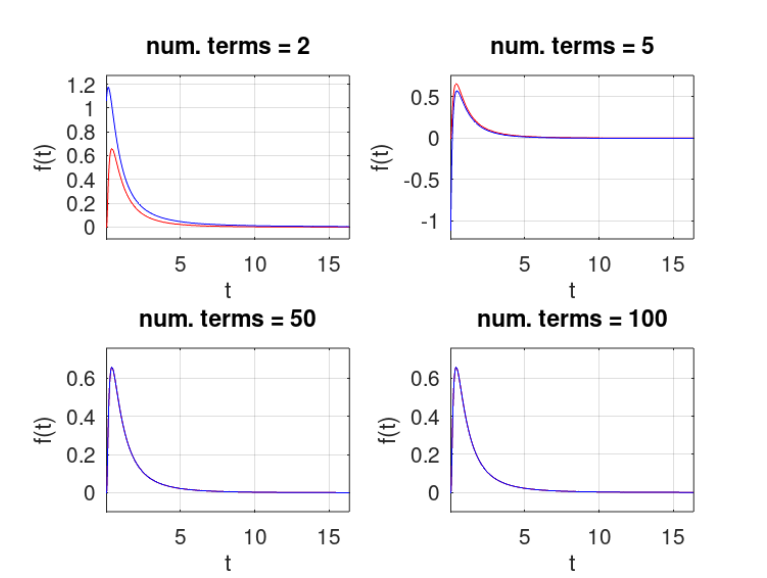
Figure 2. Numerical computation of f ( t ) (45) for 2,5,50, and 100 terms of the series. To make another fair comparison, we computed the FT of the resulting functions. In Figure 3, we present the corresponding absolute values on a logarithmic scale. A sampling interval equal to 0.0001 was used to obtain the sampled signal that was transformed using the fast Fourier transform with length 2 15 . The red line represents the spectrum of the sampled signal obtained from (1).